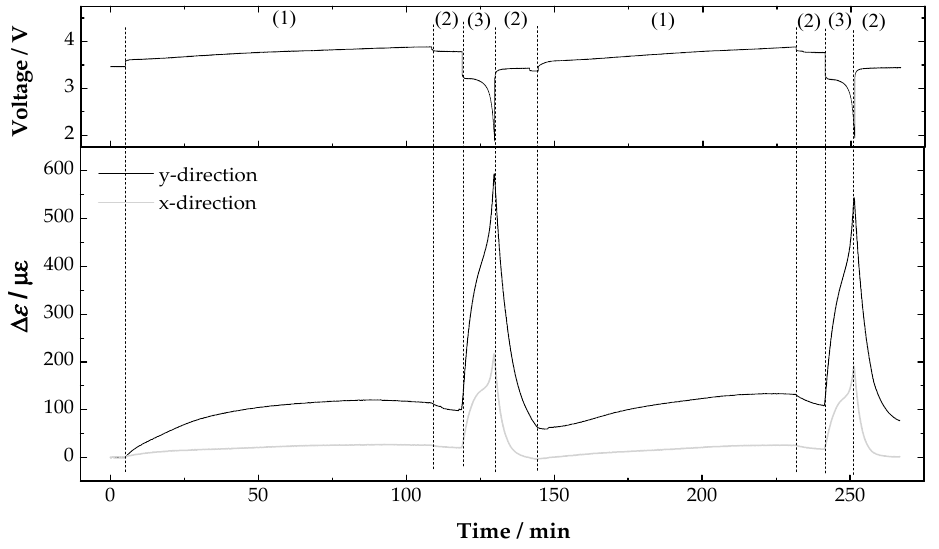
Figure 5. Voltage and strain variations recorded during two cycling tests in the battery in the x - and y -directions. ( 1 ) CC charge; ( 2 ) CV; ( 3 ) CC discharge at 5.77 C.